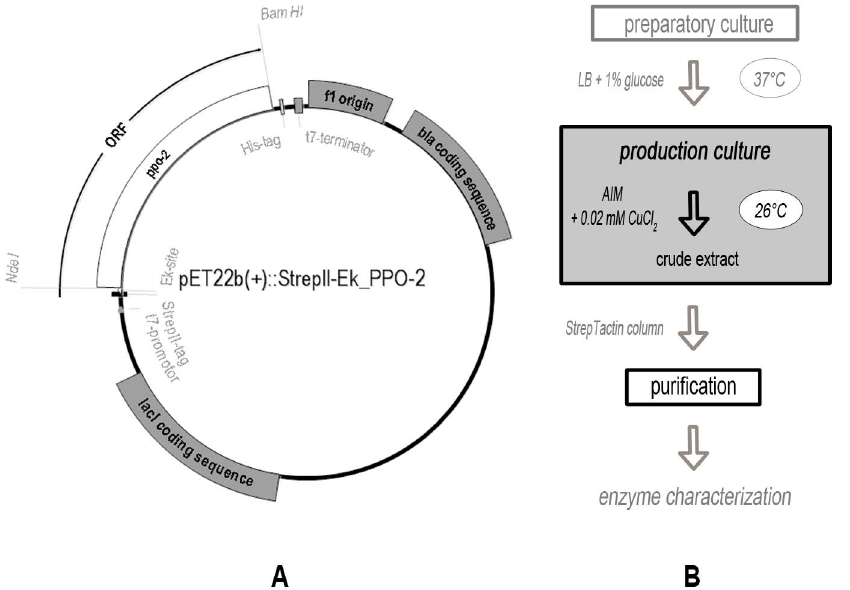
Figure 2. Expression system for dandelion PPOs. A Scheme for the PPO-2 expression plasmid. Location of important genes, regulatory elements and sites for restriction enzymes are given. The StrepII-tag (WSHPQFEK) and the Enterokinase recognition site (Ek-site: DDDDK) were introduced via PCR. ORF: open reading frame . B Procedure of heterologous PPO-expression. Conditions like media, supplements and temperatures are given and the course of action is schematized. AIM: autoinduction medium; LB: lysogeny broth